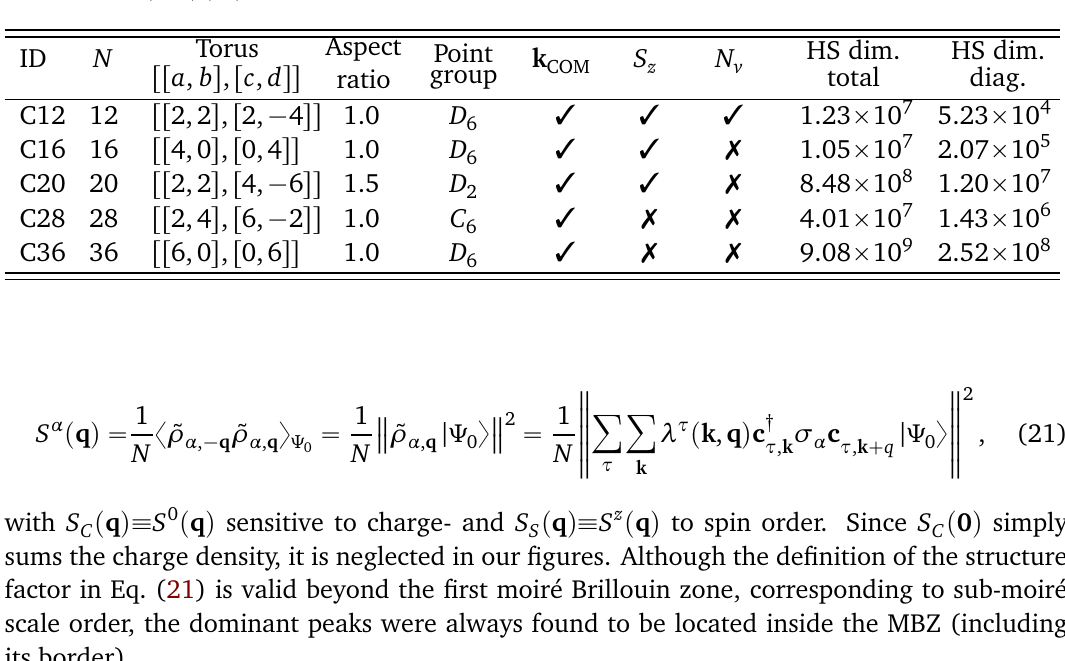
Table 1: Overview of simulation cells used for ED in this work. All clusters were chosen to have three M points to support all observed forms of symmetry